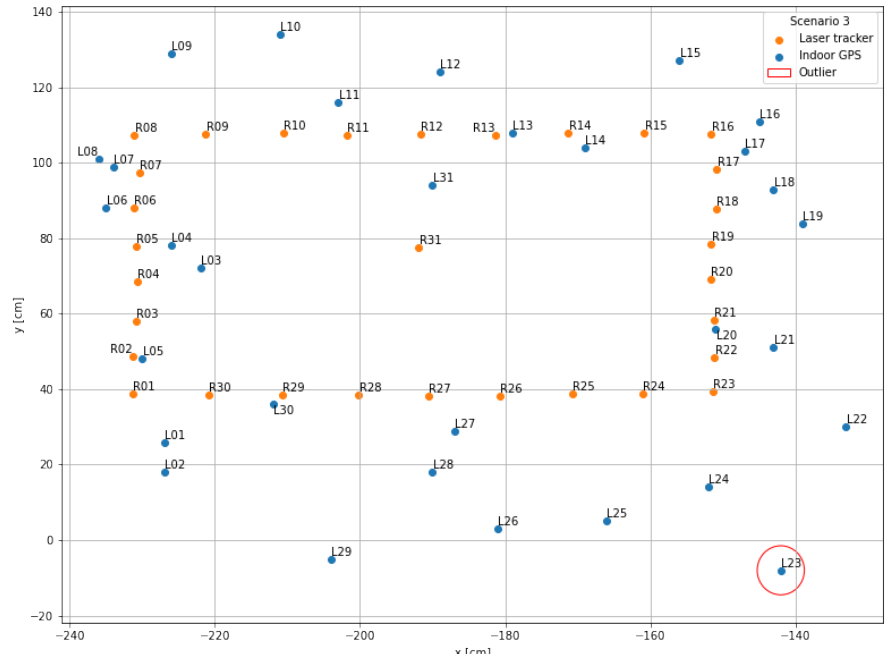
Figure 11. Data visualization scenario 3: Four lines of